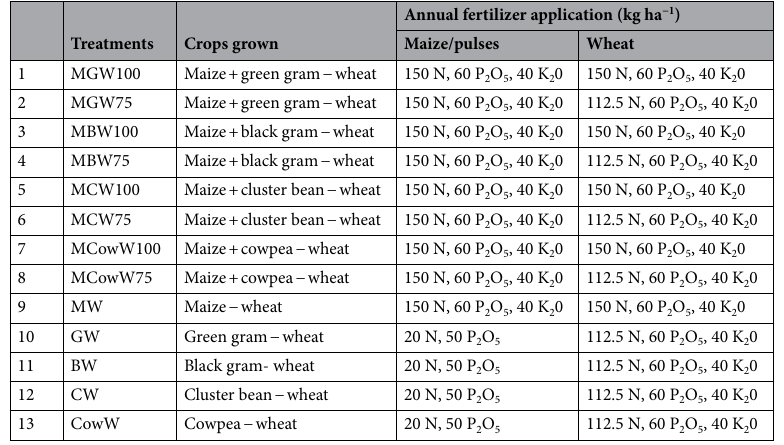
Table 1. Treatment details of the long term irrigated maize + pulses-wheat intercropping